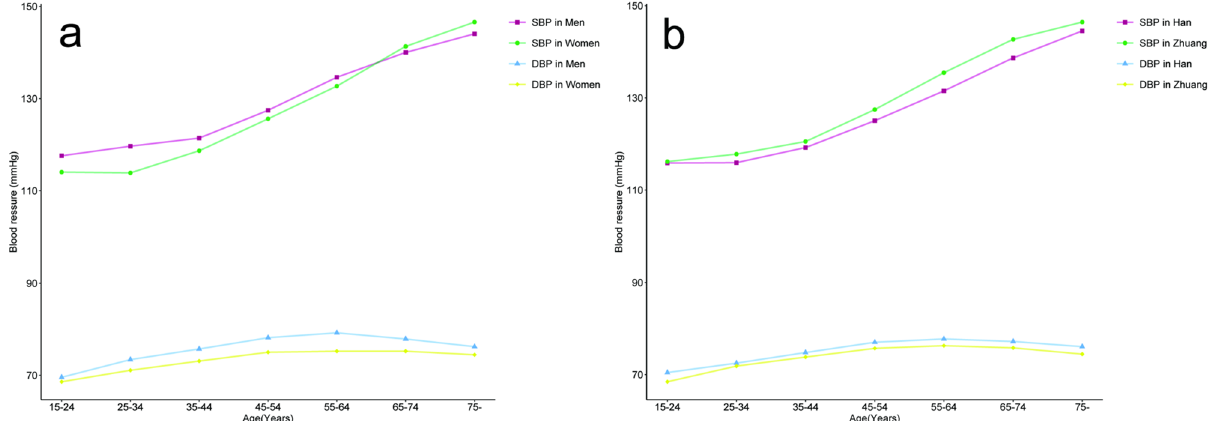
Figure 1. Blood pressure level by Sex and ethnicity. ( a ) By sex, ( b ) By ethnicity.